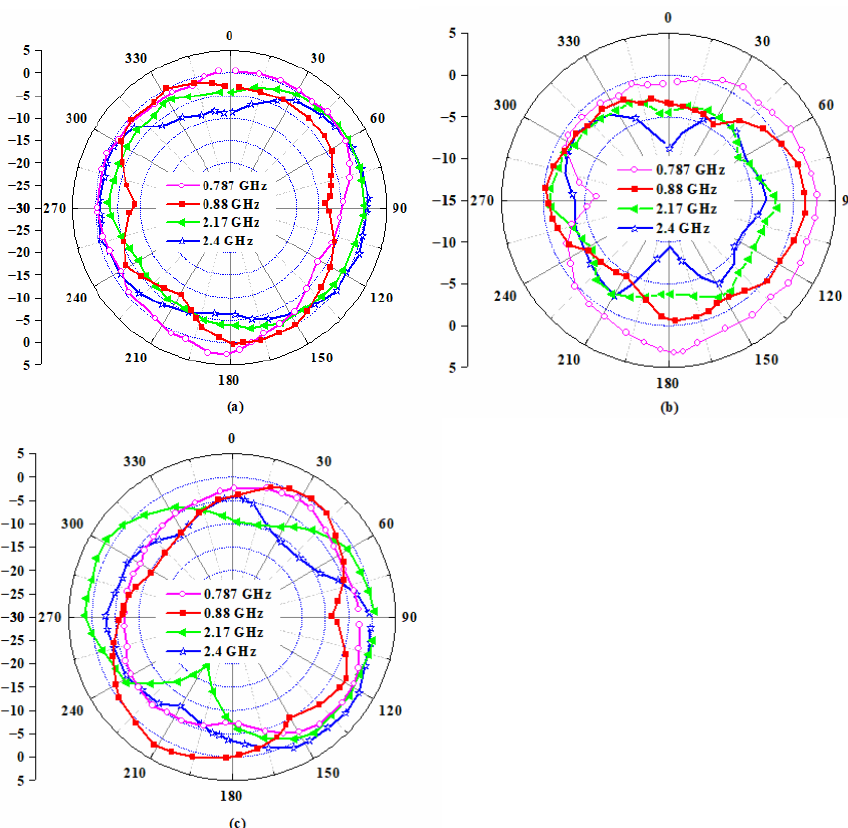
Figure 13. Measured radiation patter. ( a ) x-y plane. ( b ) x-z plane. ( c ) y-z plane.